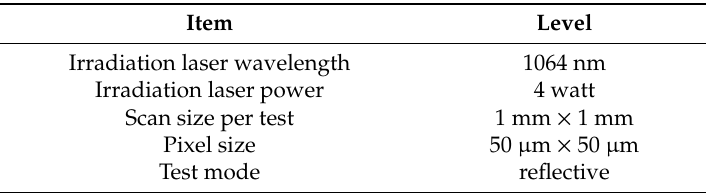
Table 12. Detection parameters.